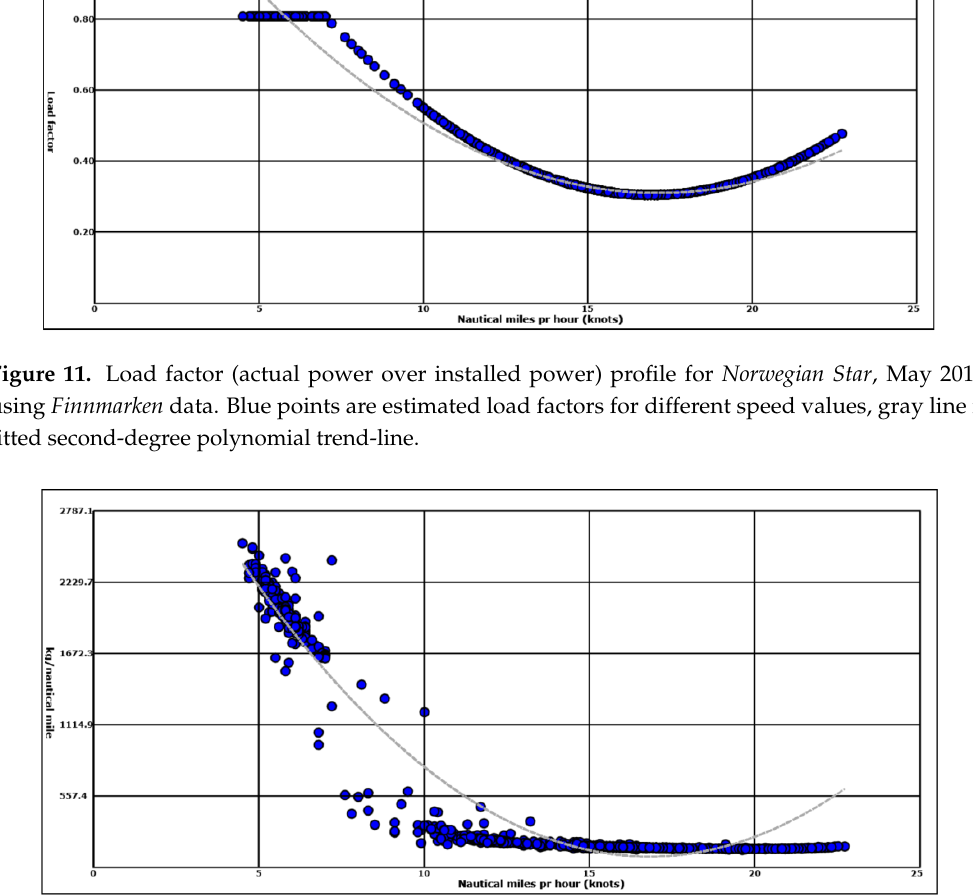
Figure 12. Propulsion fuel use profile for Norwegian Star , May 2016, using Finnmarken data for load and specific fuel consumption. Blue points are estimated kg/nautical mile for different speed values, gray line is fitted second-degree polynomial trend-line.